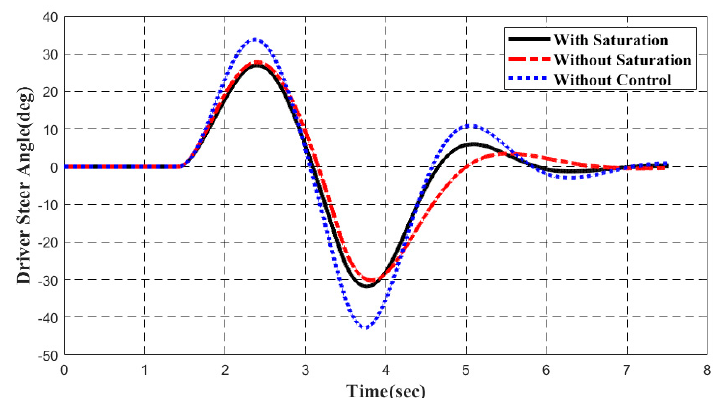
Figure 6. The simulation results for the driver steering angle. Table 1. Driver average angle.